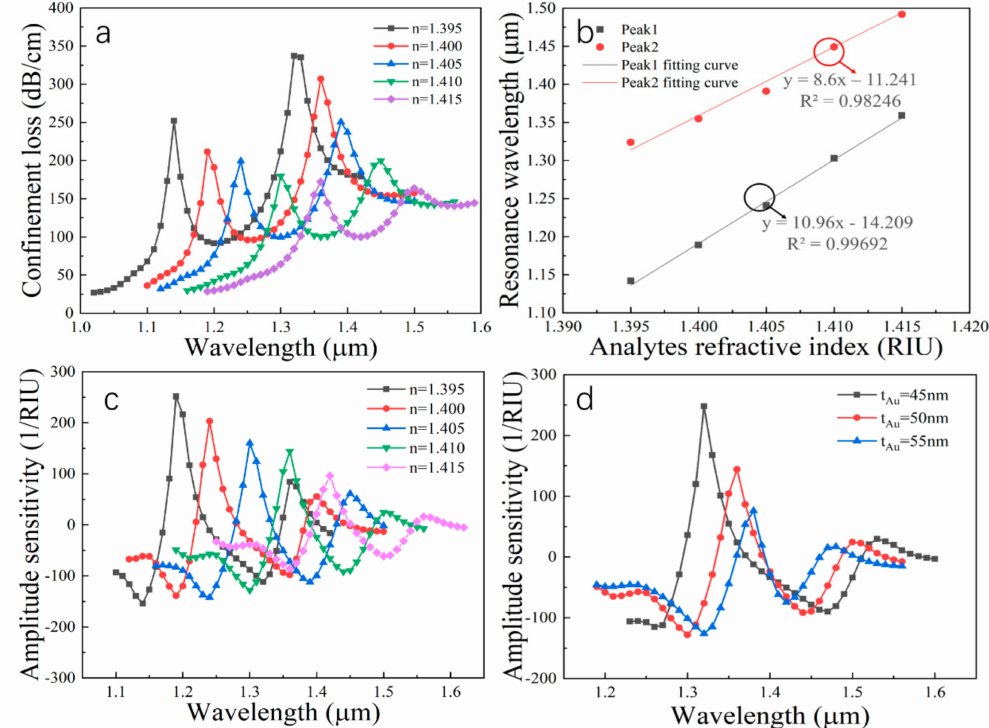
Figure 6. Performance parameters of the proposed sensor: ( a ) dependence of the loss spectra of the y-polarization fundamental mode on the analyte RI; ( b ) Linearity between the resonance wavelength and the RI of the analytes; ( c ) dependence of amplitude sensitivity on di ff erent analytes’ RI; ( d ) di ff erent gold thicknesses, n =